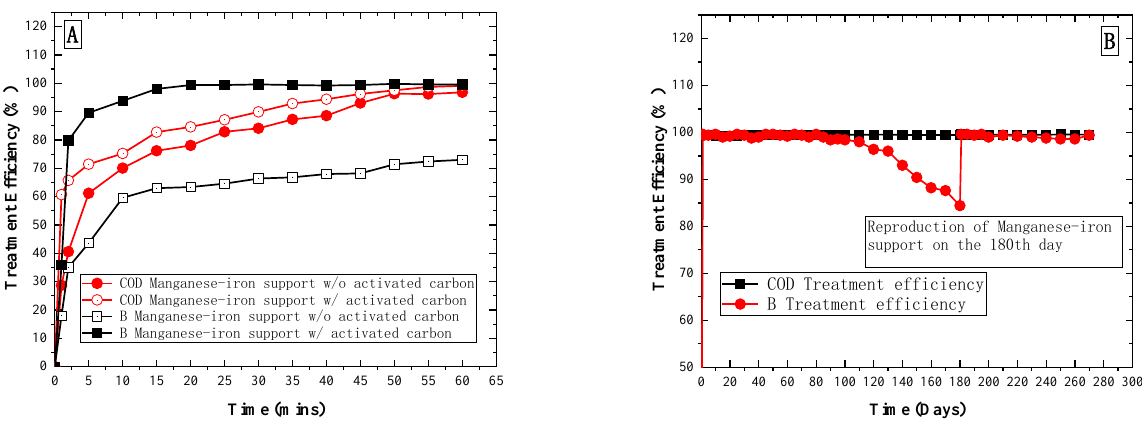
Figure 6. Catalytic treatment efficiency curve and saturation curve of manganese dioxide/iron oxide support (oxidant: H 2 O 2 ). ( A ) Mn/Iron support treatment compares with and without activated carbon ( B ) Mn/Iron support treatment at 280 days.